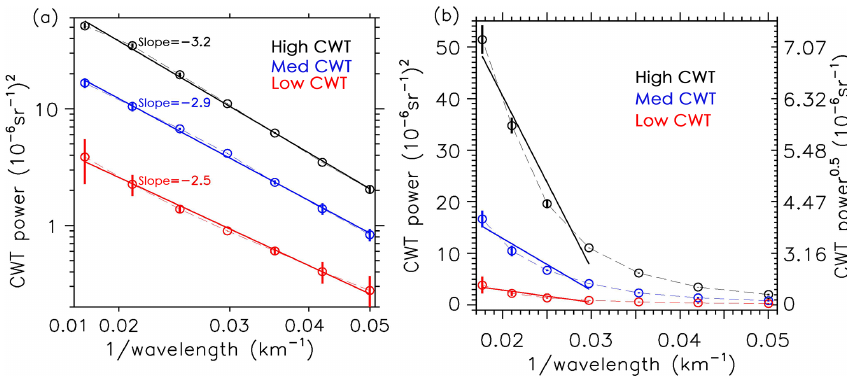
Figure 6. Albedo CWT power spectra for the nine detections selected in Fig. 4. The black, blue, and red colors correspond to the uppermost row (high albedo power), middle row (medium albedo power), and the lowermost row (low albedo power) of dots in Fig. 4a, respectively. For each albedo power category the CWT power spectra are normalized to collapse within the error bars as the 1 σ standard deviation. The exact match occurs at the medium scale ( ∼ 33km wavelength or 0.03 spatial frequency) to obtain the mean slope. The thin dashed lines are original curves, and the thicker solid lines are linear fitting lines. (a) Exponents of decay are − 3.2, − 2.9, and − 2.5 for the three categories. (b) Under linear axes it is shown that higher albedo power and larger exponent correspond to more rapid decay of the albedo power toward smaller scales, reflected by the linear fitting lines for the first few dominant